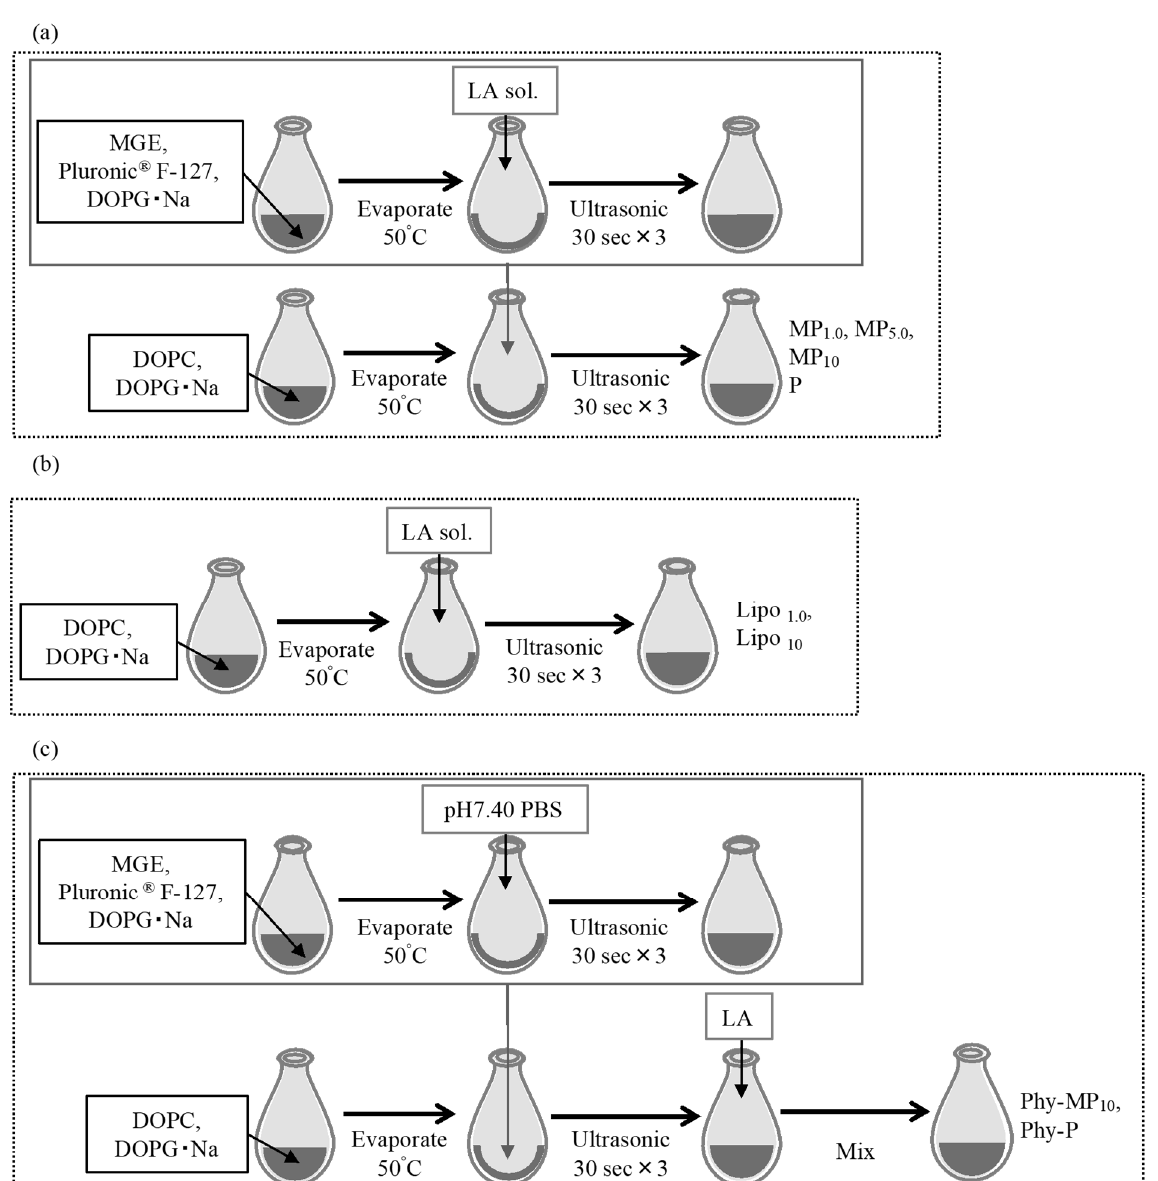
Figure 1. Schematic diagram of the preparation procedure of lipid-based self-administrated formulations. ( a ) MP and P formulations, ( b ) Lipo formulations, ( c ) Phy-MP 10 and Phy-P.